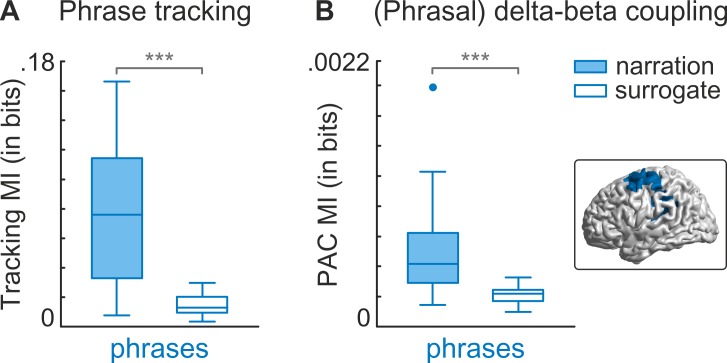
Phrase tracking and PAC in motor cortex in an additional dataset.MI values for phrase tracking and PAC were compared with surrogate data. Surrogate data were created by reversing the time series for speech and computing MI between forward brain time series and reversed speech time series. Surrogate data represent values that would be expected by chance. (A) Speech tracking at the phrasal time-scale (0.1–1.5 Hz) for real and surrogate data in the motor cortex (see inlet for analysed area). Phrase tracking was significantly larger in real data than in surrogate data. (B) MI between the phase at the phrasal timescale (0.1–1.5 Hz) and power in the beta band (13–30 Hz). PAC was significantly larger in real data than in surrogate data. Significance is denoted with: *** = p < .001. Data deposited in the Dryad repository: https://doi.org/10.5061/dryad.1qq7050 [31]. MI, mutual information; PAC, phase-amplitude coupling.